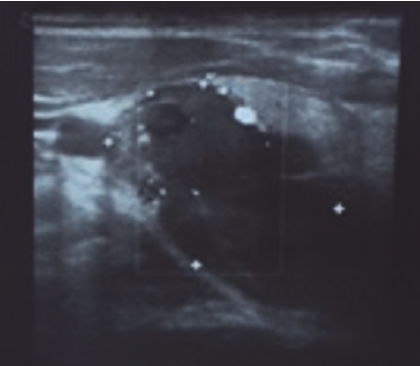
Figure 1: Thyroid ultrasound, large dominant complex 3.6 × 2.6 × 3.3 cm thyroid nodule with regular borders and peripheral vascularity in the right lobe.